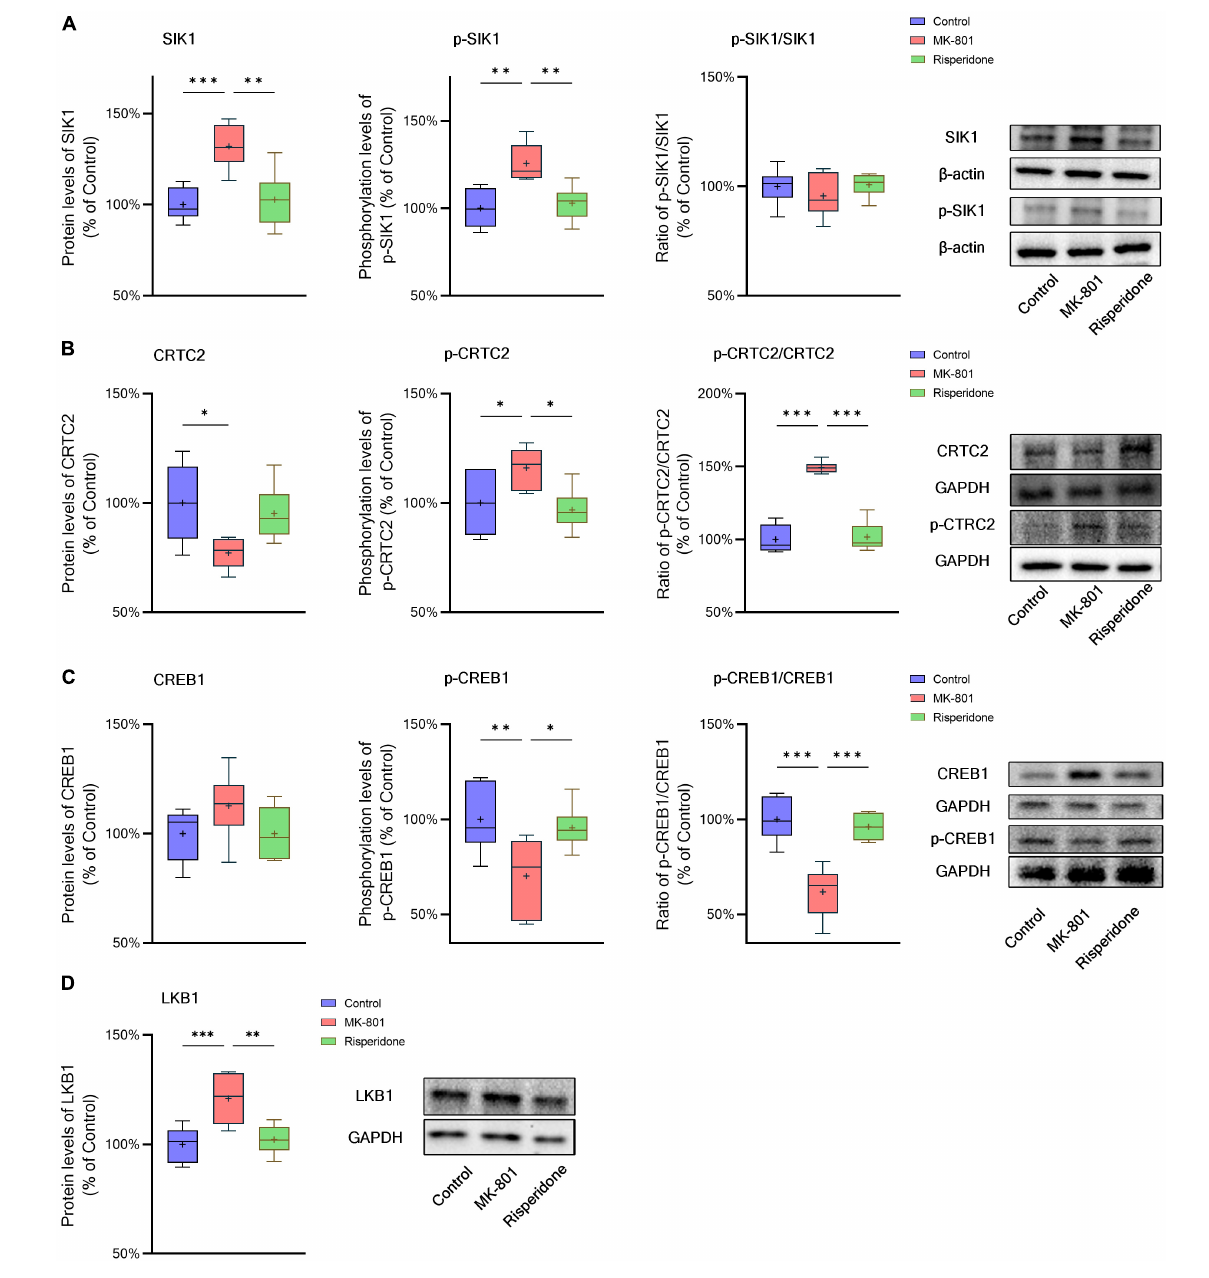
FIGURE4 Altered SIK1/CRTC2/CREB1 signaling induced by the repeated MK-801 administration in the caudate putamen. (A) The protein expression and phosphorylation levels of SIK1 were altered by MK-801, but the ratio of p-SIK1/SIK1 did not change. (B) The phosphorylation of CRTC2 in the model rat caudate putamen (CPu) was up-regulated by MK-801, but reversed by risperidone. (C) The phosphorylation of CREB1 in the model rat CPu was inhibited, which was restored by risperidone. (D) The protein expression of LKB1 was increased by MK-801, which was also eliminated by risperidone. ∗ P < 0.05, ∗∗ P < 0.01, ∗∗∗ P < 0.001, + mean